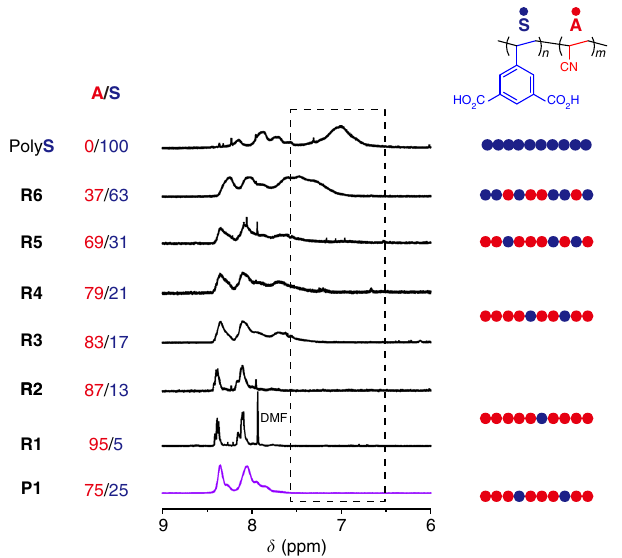
Fig. 4 Structural characterization of polymers using 1 H NMR. The 1 H NMR spectra of (co)polymers synthesized in 1S ( P1 ) and in DMF ( R1 - 6 and poly S ). With decreasing S unit in polymers prepared in DMF, peaks for the aromatic protons of the S unit (6.5 – 8.5 ppm) shifted to lower magnetic fi eld because of the lower shielding effect around S in A -rich copolymers. Although the composition of S in P1 is larger than those of R3 and R4 , peaks at 6.5 – 7.6 ppm were not observed, indicating that S units in P1